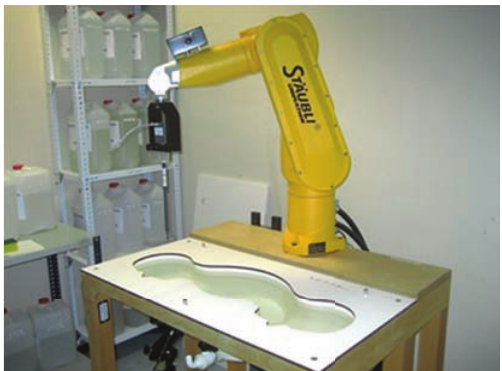
F 4: SAR measurement system. e wireless handheld device radiating RF power is attached to a phantom cheek. A probe mea- sures the electrical �eld generated by the device inside a phantom �lled with liquids emulating the human tissue at the frequencies of